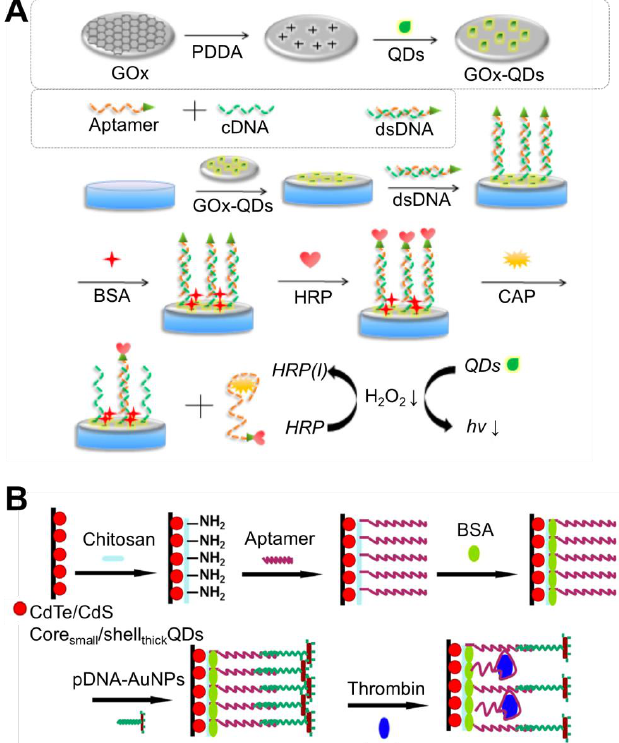
Figure 3. Quantum dot (QD) biosensing strategy based on change in optical signal of QD by materials indirectly linking with the aptamer ( A ) glassy carbon electrode (GCE)-deposited CdS QD-gra- phene oxide (GOx) composite biosensor to detect chloramphenicol. Reproduced with permission from [47]; ( B ) GCE-deposited CdTe/CdS QD biosensor to detect thrombin. Reproduced with per- mission from [48]. PDDA, Poly(diallyldimethylammonium chloride); cDNA, complementary DNA; dsDNA, double-stranded DNA; BSA, bovine serum albumin; HRP, horseradish peroxidase; CAP, chloramphenicol, pDNA-AuNP, probing DNA-modified gold nanoparticle.